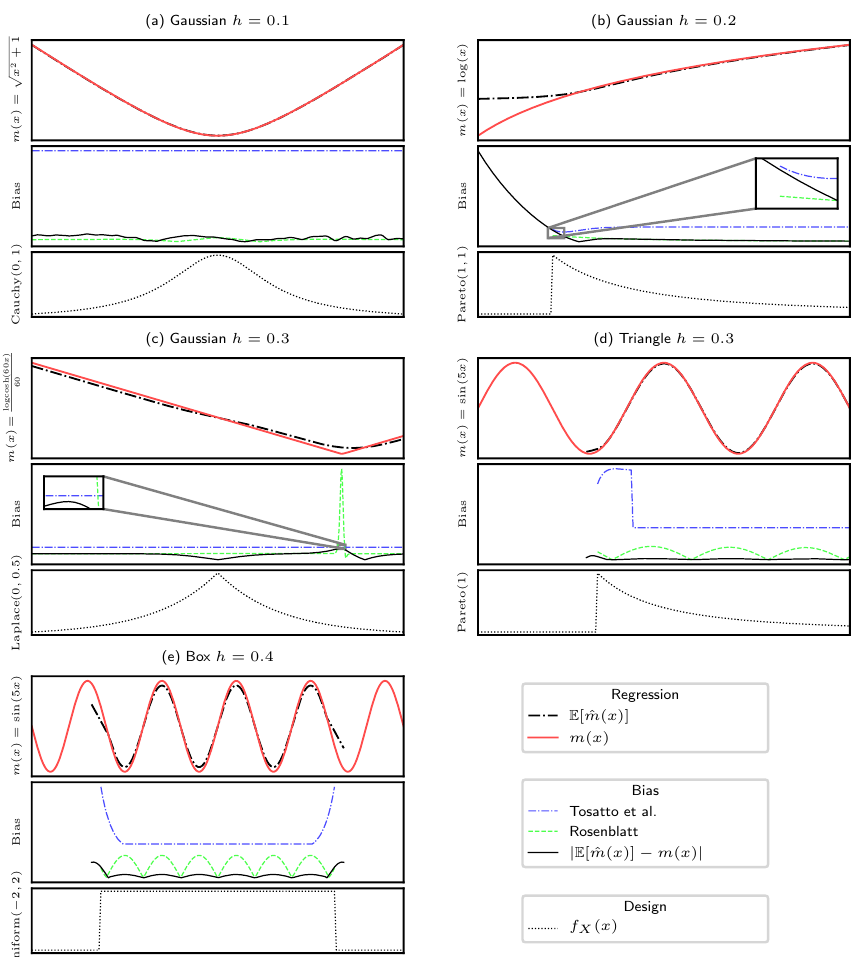
Figure 1. We propose some simulations of Nadaraya-Watson regression with different designs, regression functions, and bandwidths. ( a )–( c ) use Gaussian kernels, while ( d ) and ( e ) use Triangle and Box kernels, respectively. The regression function m ( x ) is represented with a solid line, while the Nadaraya-Watson estimate ˆ m ( x ) is represented with a dash-dotted line in the top subplot of each experiment. In the second subplots, it is possible to observe the true bias (solid line), as well as our upper bound (dashed line) and Rosenblatt’s estimate (dash-dotted line). The bottom subplots depict the design used. The bandwidth used for the estimation is denoted with h . It is possible to observe that Rosenblatt’s estimate often under or overestimates the bias, e.g., subfigures ( b ) and ( c ). In all the different test conditions, our method correctly upper bounds the